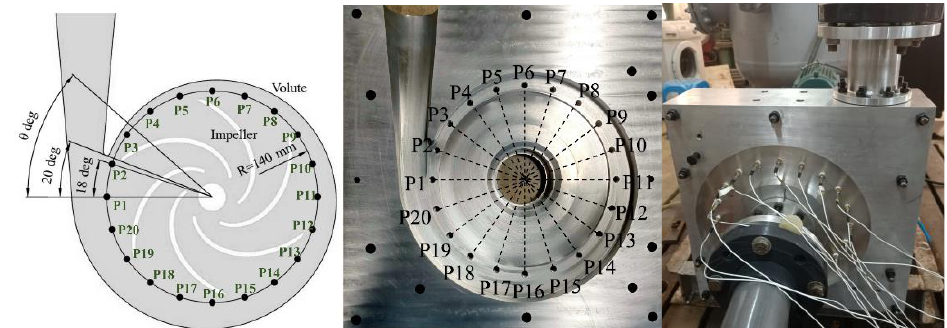
Figure 3. Measuring position of the pressure sensor.